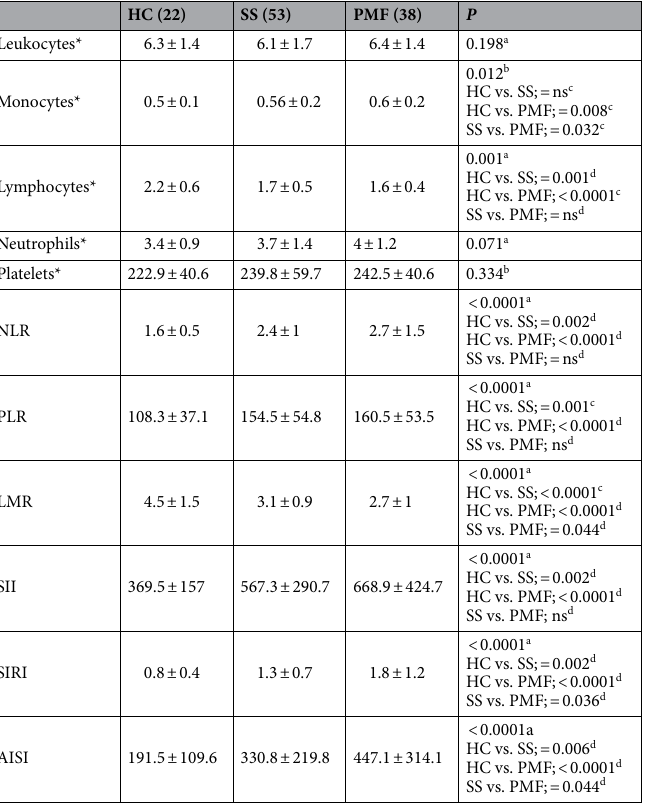
Table 2. White blood cell counts and leukocyte subset indices. NLR (neutrophil/lymphocyte ratio), PLR (platelet/lymphocyte ratio), LMR (lymphocyte/monocyte ratio), SII (neutrophil x platelet/lymphocyte ratio), SIRI (neutrophil x monocyte/lymphocyte ratio) and AISI (neutrophil x monocyte x platelet/lymphocyte ratio). *(× 10 3 cell/µl). Data represent mean ± standard deviation. a Kruskal–Wallis test, b ANOVA, c Student´s T-test, d Mann–Whitney- U test. P , p value; ns non-significant.